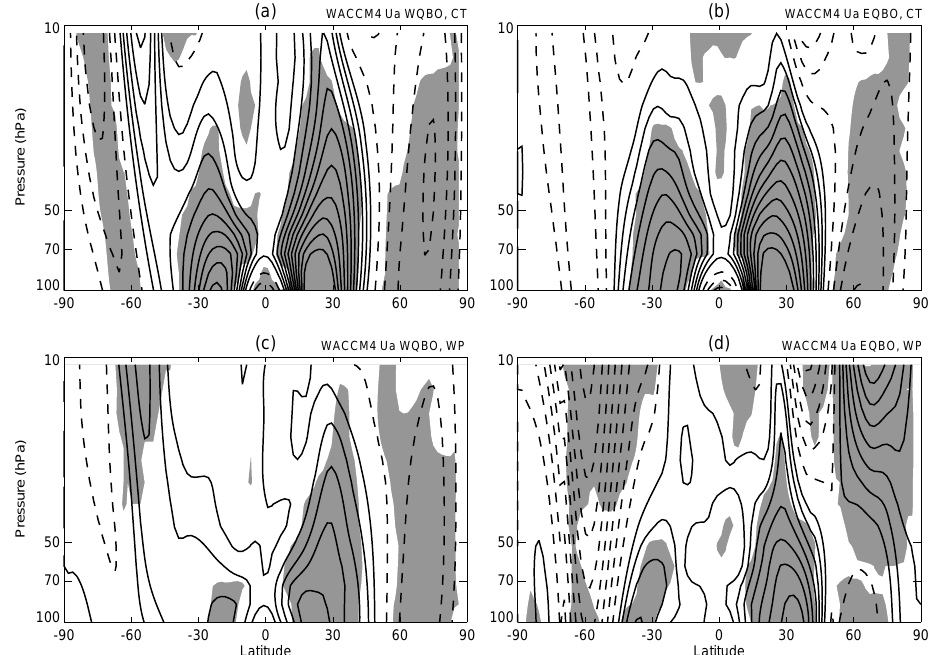
Fig. 10. Differences of the zonal wind for R2–R1 when QBO in (a) west phase and (b) east phase. The contour interval for zonal wind anomalies is ± 0.25ms − 1 . Solid and dashed lines represent positive and negative anomalies, respectively. Anomalies that are significant at the 90% confidence level according to Student’s t-test are shaded. (c) and (d) are same as (a) and (b) , but for